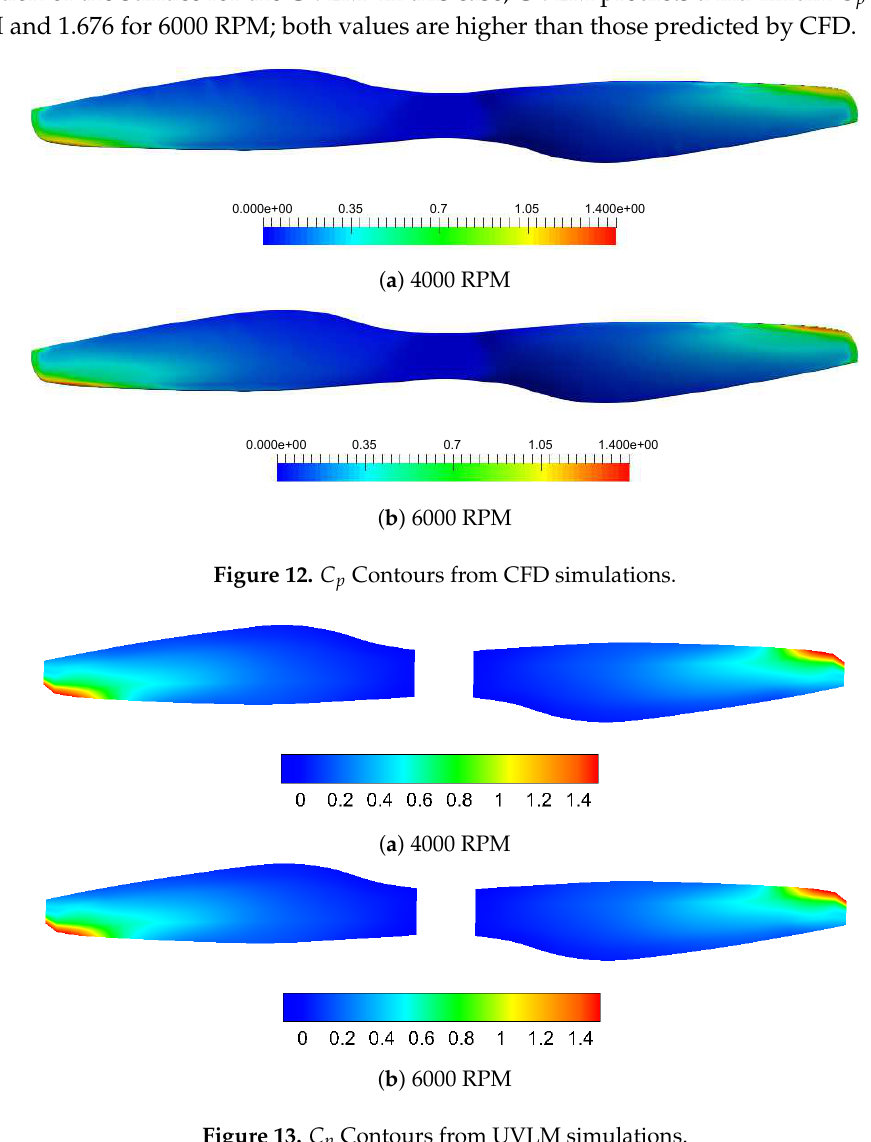
Figure 13. C p Contours from UVLM